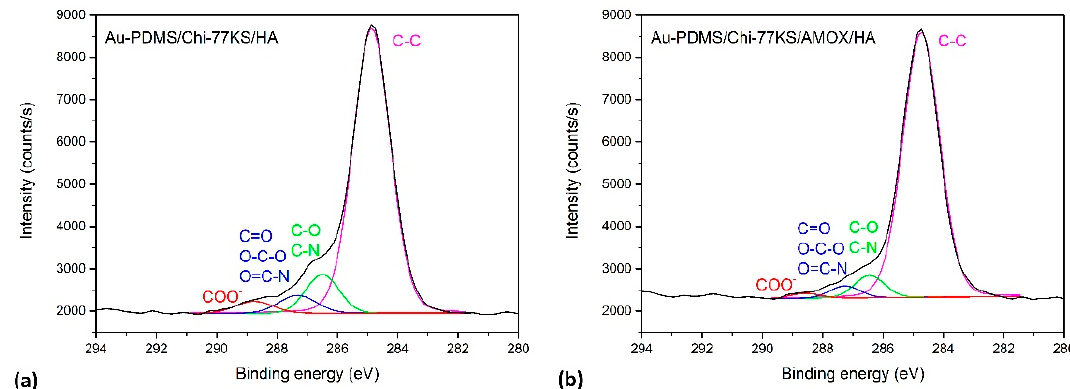
Figure 6. High-resolution XPS deconvoluted spectra of ( a ) Au-PDMS/Chi-77KS/HA and ( b ) Au-PDMS/Chi- 77KS/AMOX/HA.